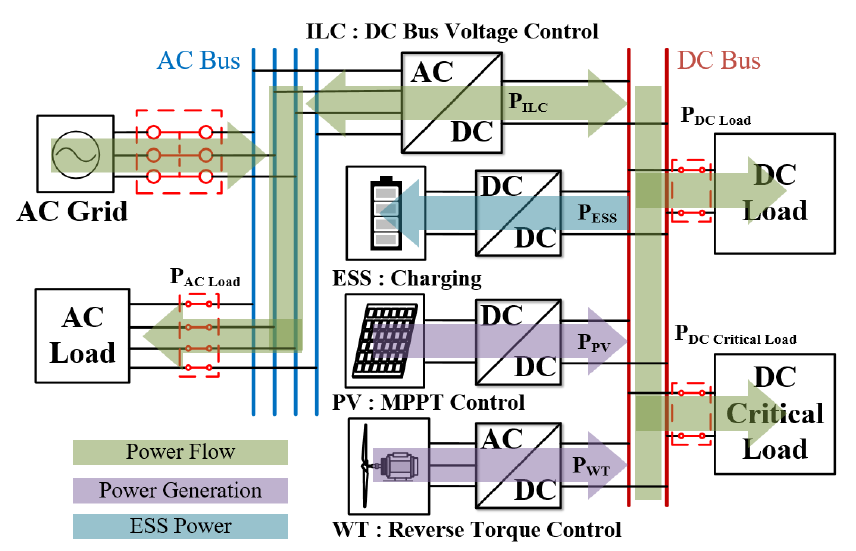
Figure 10. Mode 1: ESS Discharging.